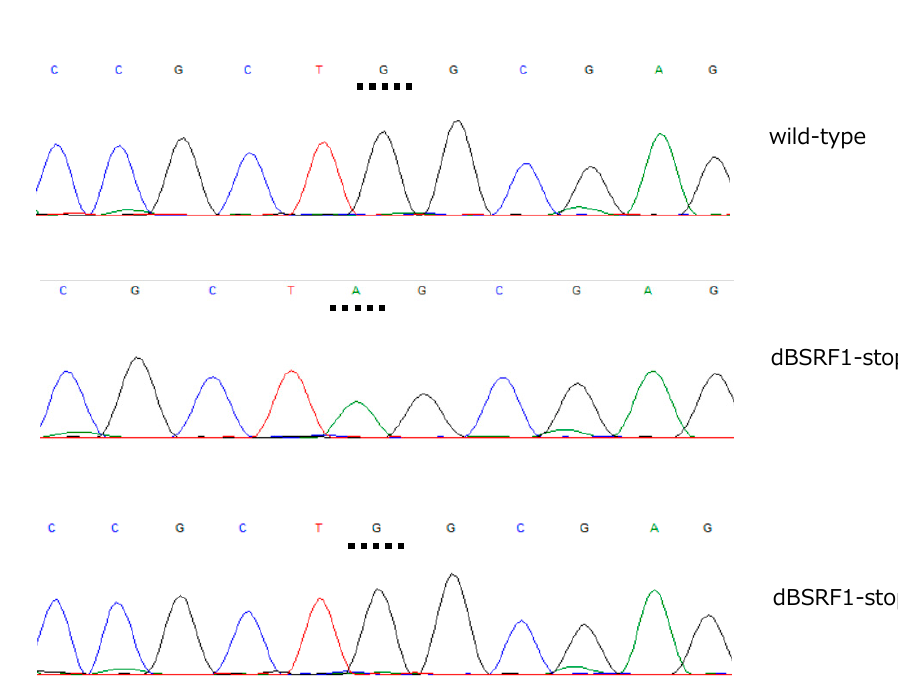
Figure 1. Construction of the Bam HI S rightward reading frame 1 (BSRF1) knockout (KO) mutant. ( A ) Schematic representation of the recombination of the Epstein–Barr virus (EBV)-bacterial artificial chromosome (BAC) genome using neomycin- and streptomycin-sensitivity genes in tandem (Neo/St). The insertion mutant was produced by inserting a Neo/St cassette at nucleotides 116 and 117 of the BSRF1 gene. To construct the KO virus (dBSRF1-stop), the cassette was replaced by the BSRF1 sequence with a stop codon. The same cassette was again inserted to prepare the intermediate, and replaced with the wild-type BSRF1 sequence to generate the repaired strain, dBSRF1-stop/R. ( B ) Agarose gel electrophoresis of recombinant EBV-BAC DNA treated with BamHI and EcoRI. ( C ) Sequence data of the recombinant